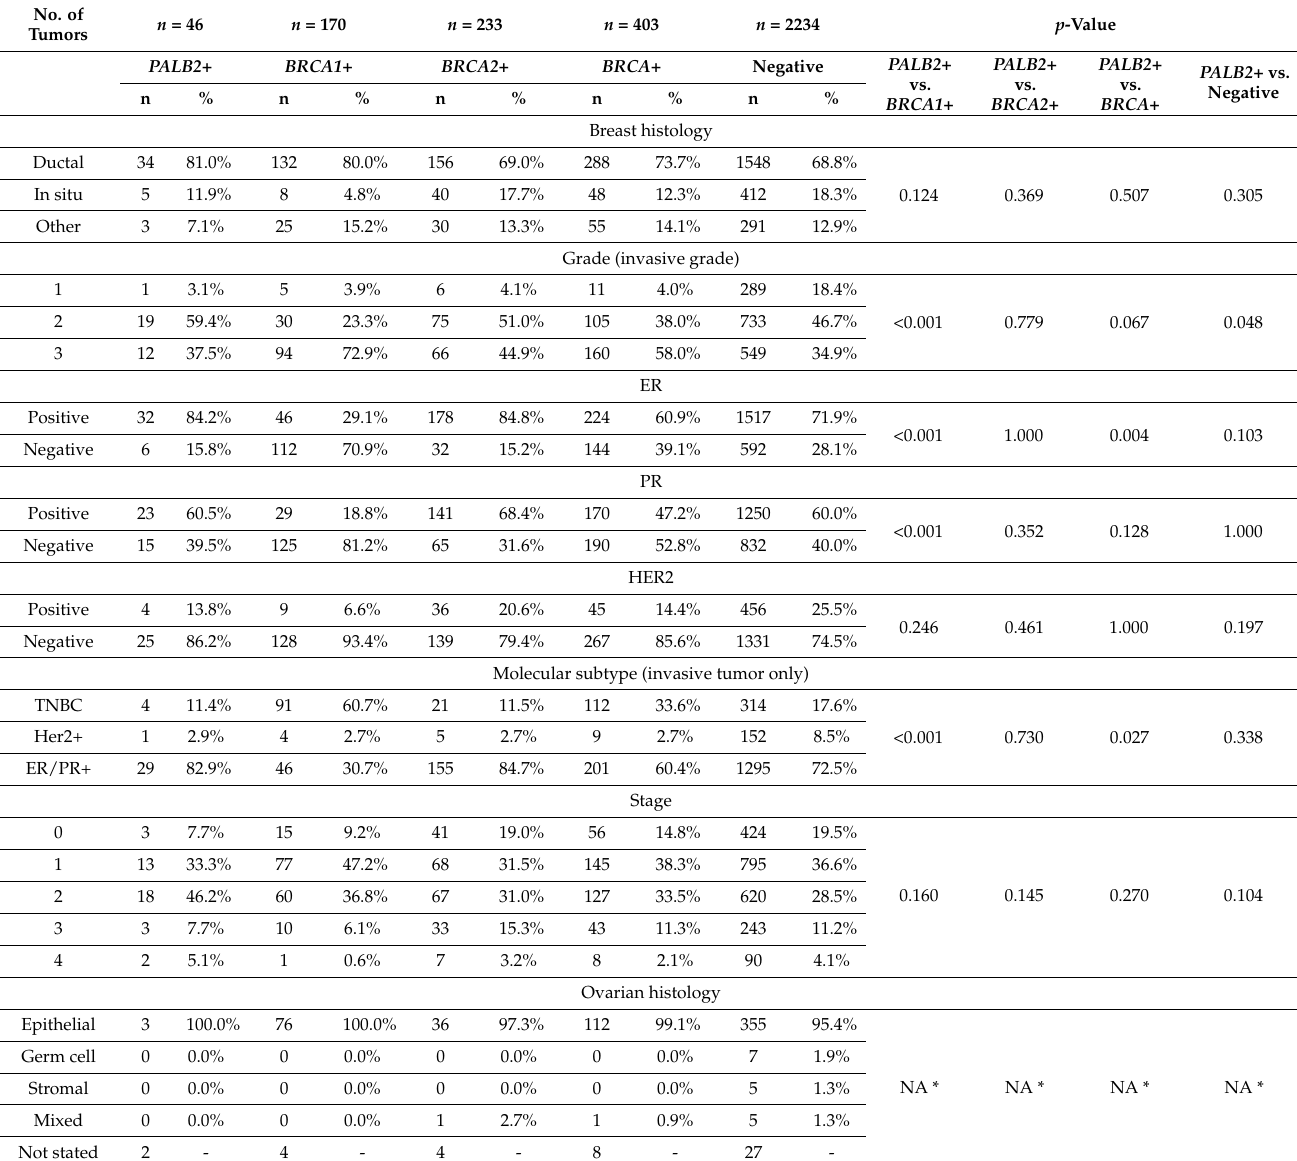
Table 3. Pathological characteristics and mutation frequencies of PALB2 and BRCA1/2